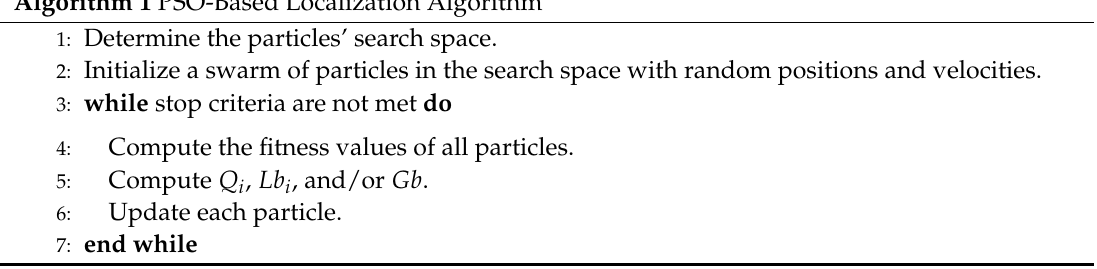
Algorithm 1 PSO-Based Localization